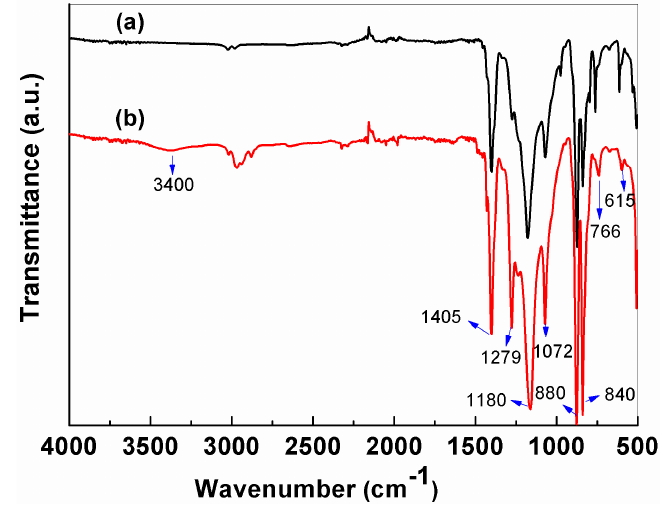
Figure 3. Fourier transform infrared spectroscopy (FT ‐ IR) spectroscopy for: ( a ) PVDF ‐ NMs, ( b ) PVDF ‐ TLNMs ‐ 3.